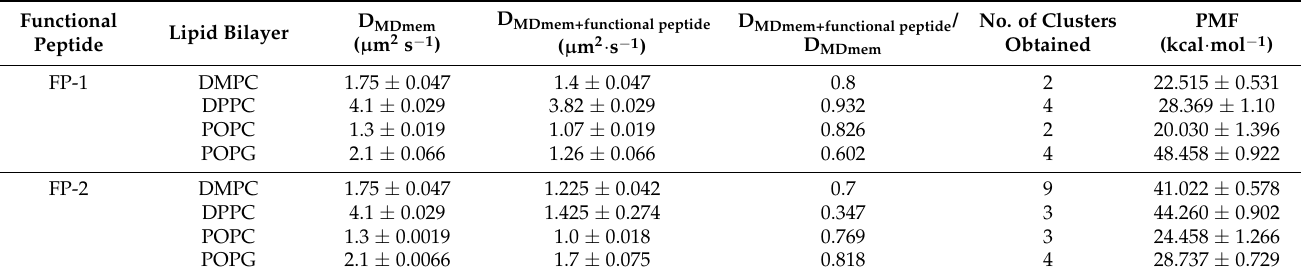
Table 1. Measured dynamic, structural, and energetic properties from atomic-resolution simulations of the functional peptides a